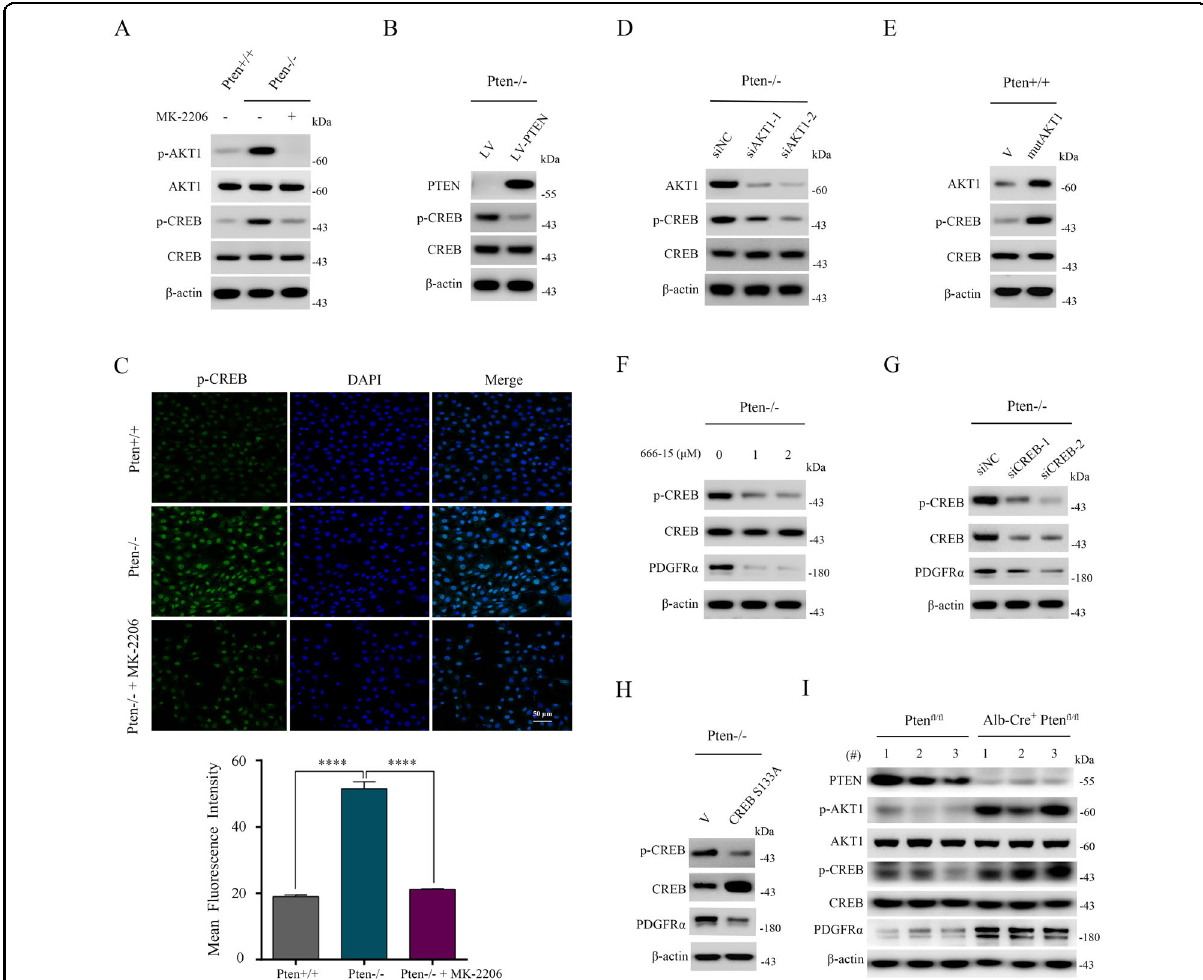
Fig. 2 The PTEN-AKT1 signaling pathway increases PDGFR α expression through the activation of CREB. A , C Pten + / + , Pten − / − MEFs, and MK-2206 (5 μ M, 24 h) treated Pten − / − MEFs. B Pten − / − MEFs were infected with LV-PTEN or LV lentiviruses. C The expression of p-CREB was analyzed by an immuno fl uorescence assay. Representative images were presented (upper panel).Scale bar, 50 μ m. Mean fl uorescence intensity was calculated by software ImageJ (lower panel). D Pten − / − MEFs were transfected with siNC, siAKT1-1, or siAKT1-2 for 48 h. E Pten + / + MEFs transduced with the retroviruses for AKT1E17K (mutAKT1) in pLXIN or its control vector pLXIN (V). F Pten − / − MEFs were treated with or without 666- 15 (1 or 2 μ M) for 24 h. G Pten − / − MEFs were transfected with siNC or two independent siRNAs against CREB (siCREB-1 and siCREB-2) for 48 h. H Pten − / − MEFs transduced with the retroviruses for CREB S133A in pLXIN or its control vector pLXIN (V). I The whole liver lysates from liver-speci fi c Pten knockout mice (Alb-Cre + Pten fl / fl ) and the control mice (Pten fl / fl ). n = 3. A , B , and D – I Cell or tissue lysates were subjected to immunoblotting with the indicated antibodies. Error bars indicate mean ± SD of triplicate samples. **** P <